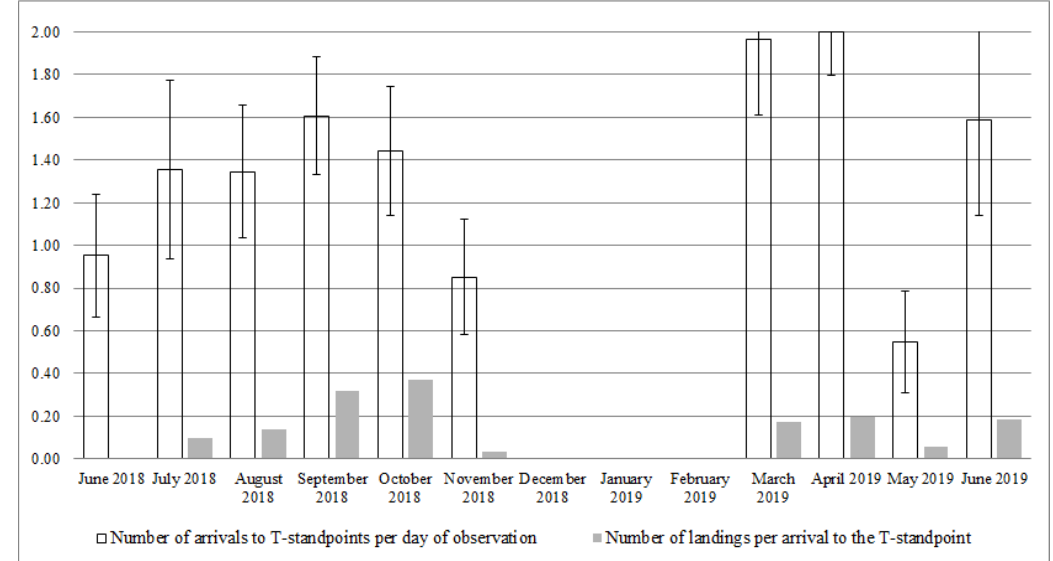
Figure 2. Average number of arrivals to T-standpoints per day of observation and landings to the ground per attending the T-standpoint. Vertical bars show confidence intervals of arithmetic mean (α = 0.05)